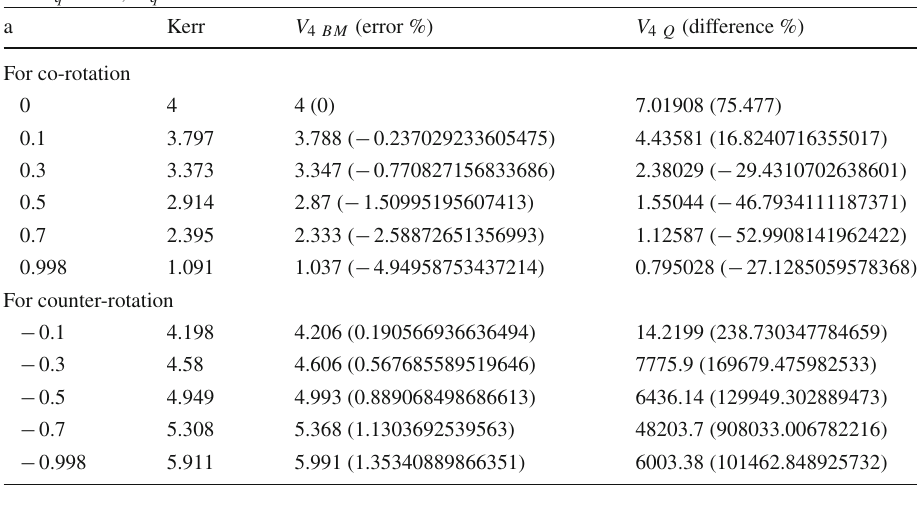
PNPs for relatively high DE effect of a BH embedded in